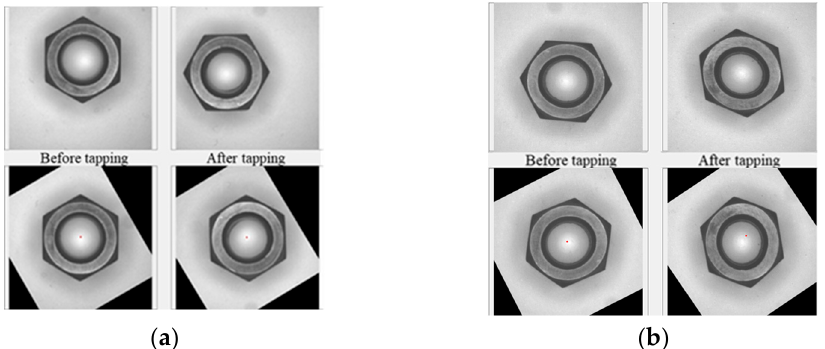
Figure 12. Using the coincidence of the nut before and after tapping to calculate eccentricity without damaging the outer appearance of the nut: ( a ) normal result; ( b ) abnormal result.